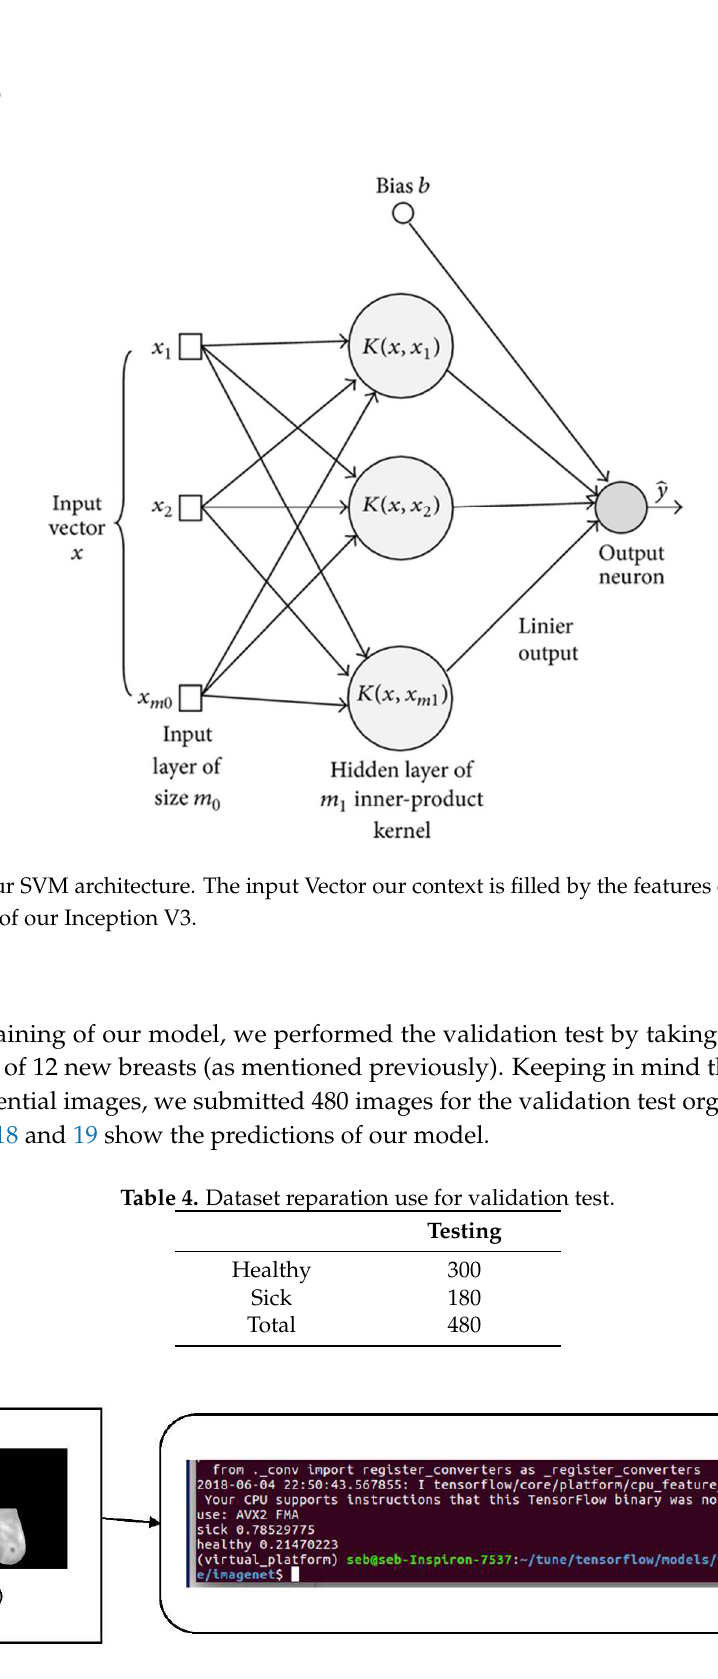
Figure 18. Given image ( A ) as input, our model classifies the image as “sick” with a confidence of 0.78.